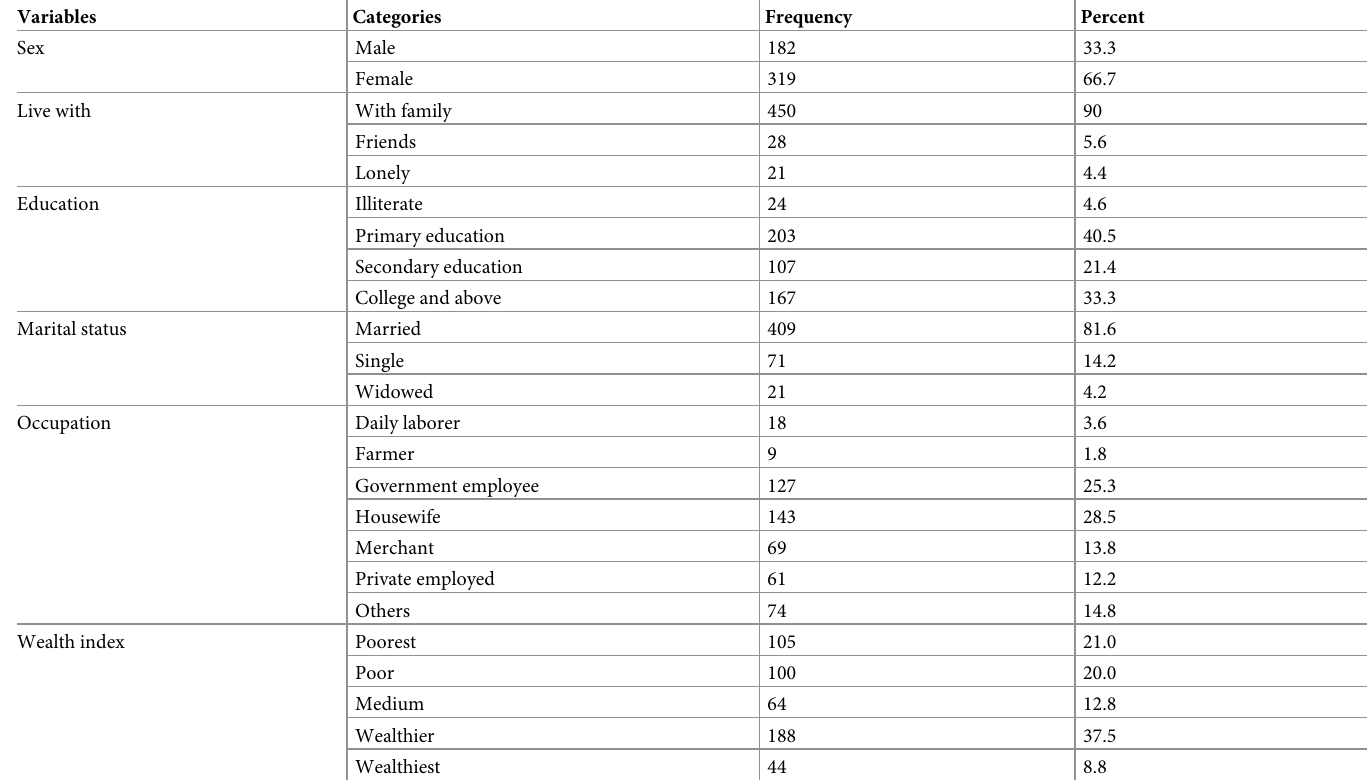
Table 1. Sociodemographic characteristics of respondents for a dietary pattern study in Dire Dawa and Harar, eastern Ethiopia. Variables